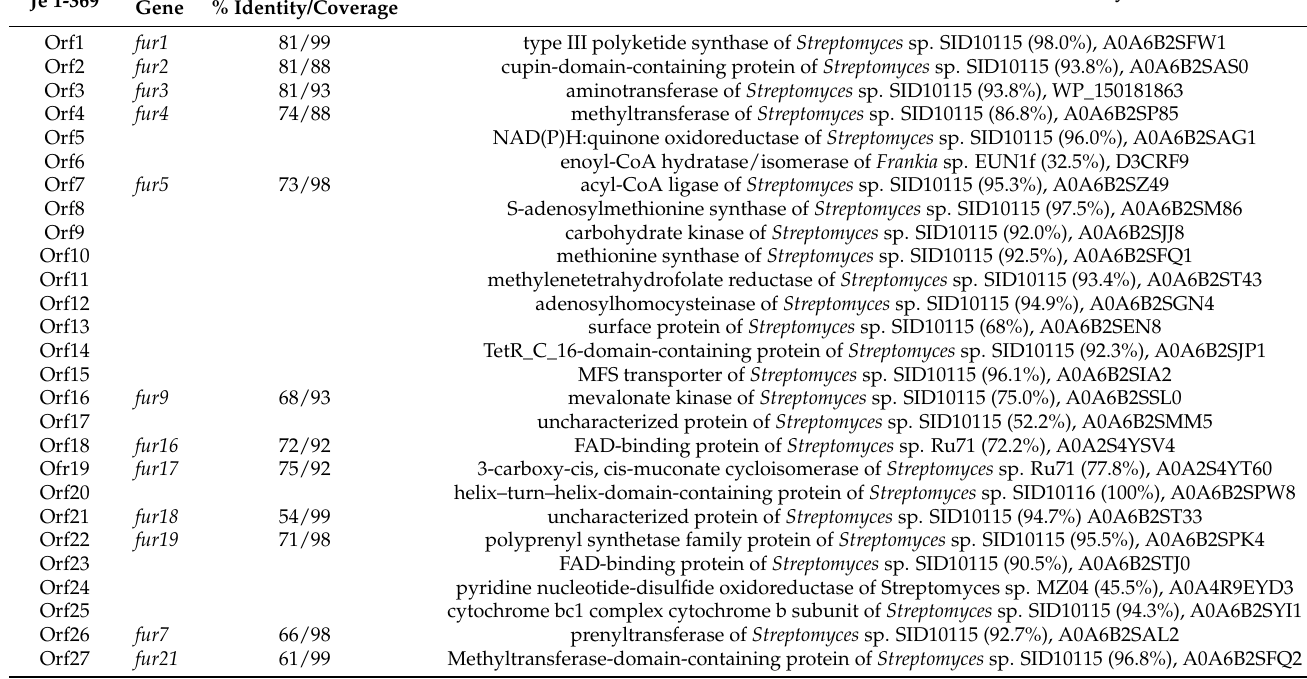
* Open reading frame. ** Best match found by UniProt Protein–Protein BLAST.